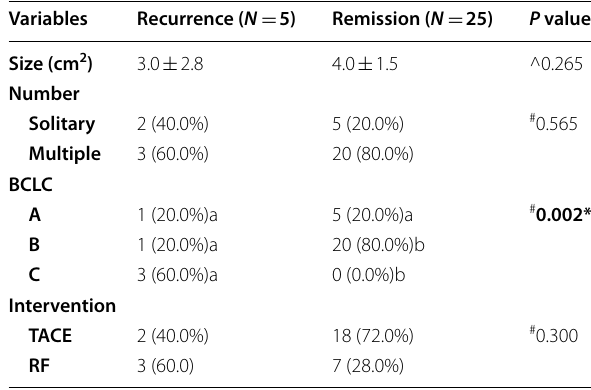
Table 6 Comparison according to tumor recurrence among HCC group regarding tumor characteristics